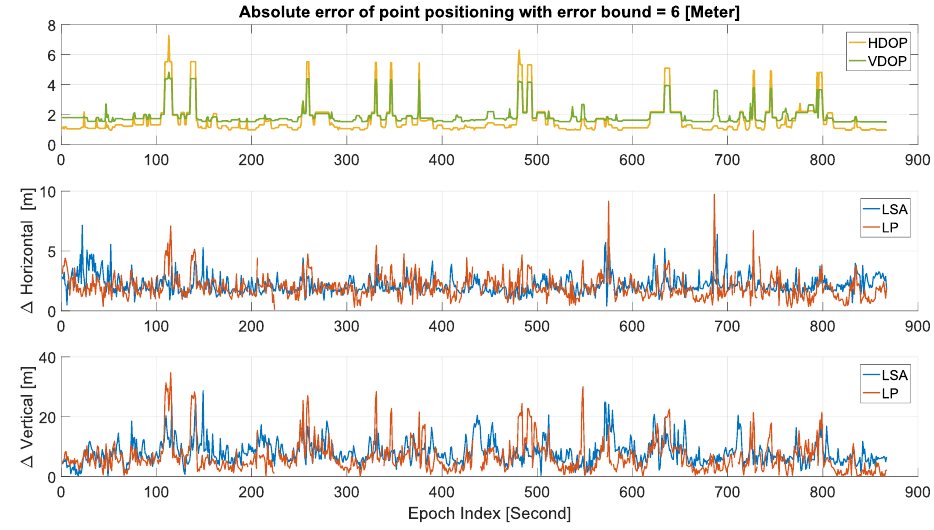
Figure 11. Point positioning errors in horizontal and vertical directions for the trajectory of Figure 10b. Top panel: DOPvalues, Middle panel: horizontal error in (m), Bottom panel: vertical position error in